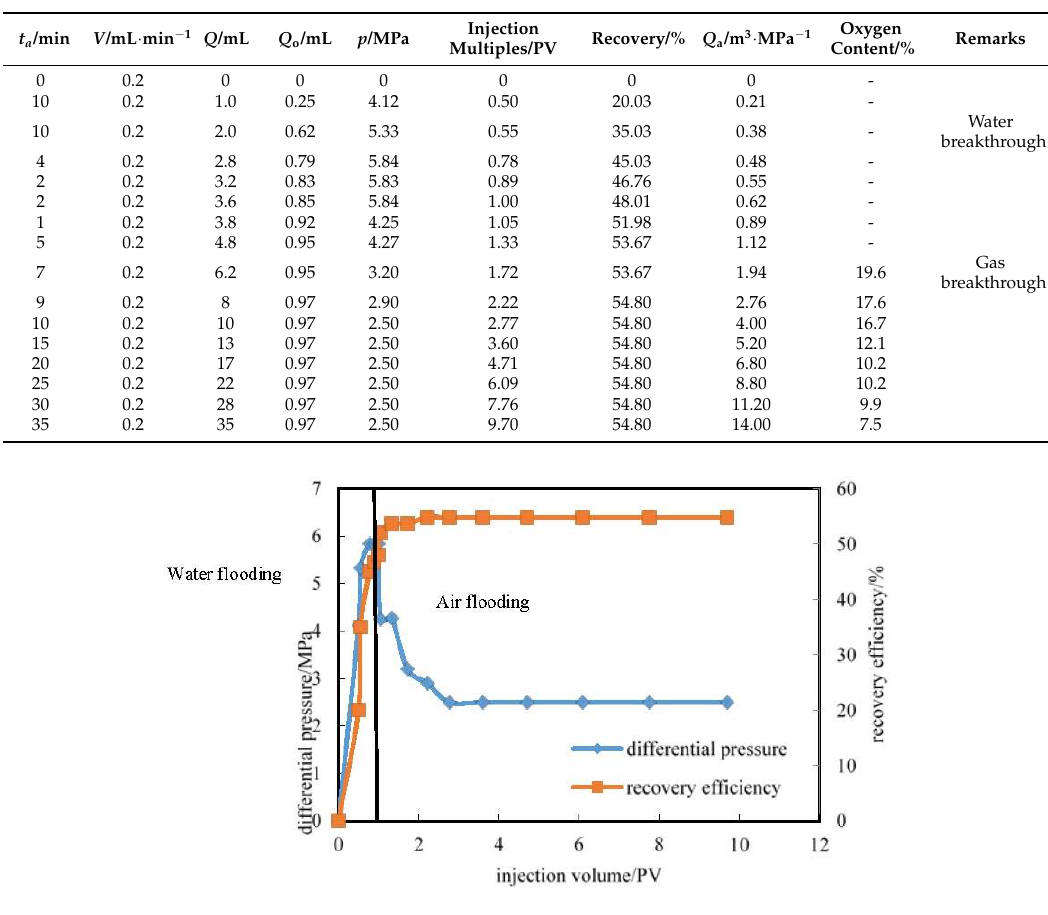
Table 8. Switch to air injection experimental results.